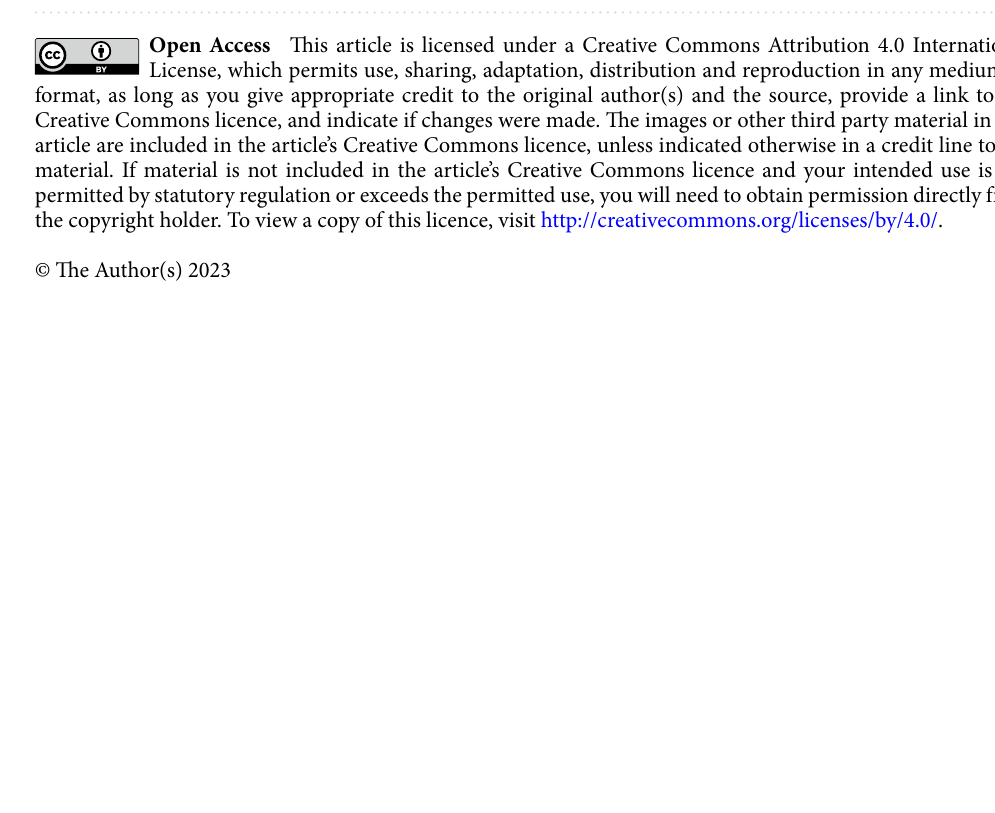
Figure 3. Brain synaptic proteins including PSD95 ( A ) and synaptophysin ( B ) and Alzheimer’s related proteins including the ratios of Amyloid-β/APP ( C ) and phosphorylated-TauThr181/Tau ( D ) of β-thalassemic mice fed with either normal diet or high-iron diet. Three replicates of cropped representative bands for brain FGF21 signaling proteins are shown ( E ). In addition, full-length blots are presented in Supplementary Fig. 2. The samples derive from the same experiment and that gels/blots were processed in parallel. Actin was used as a loading control and the density of detected protein was divided by the density of actin from the sample. APP amyloid precursor protein, HFe high-iron diet fed mice, HT heterozygous-β knockout, ND normal diet fed mice, PSD95 post-synaptic density 95. *p < 0.05 vs. HT-mice fed with normal